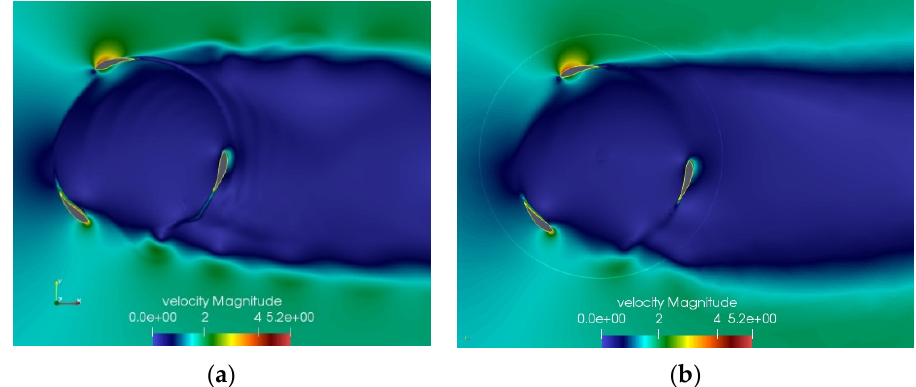
Figure 11. Instantaneous velocity magnitude field at TSR = 2 and azimuthal angle of 15 ◦ for ( a ) OM and ( b ) SM.